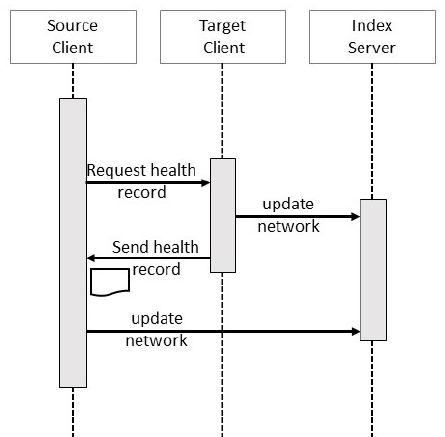
Figure 2. Transfer Request Operation. This operation is used by the patient to request a health record from the health provider or by the health provider to request a health record from the